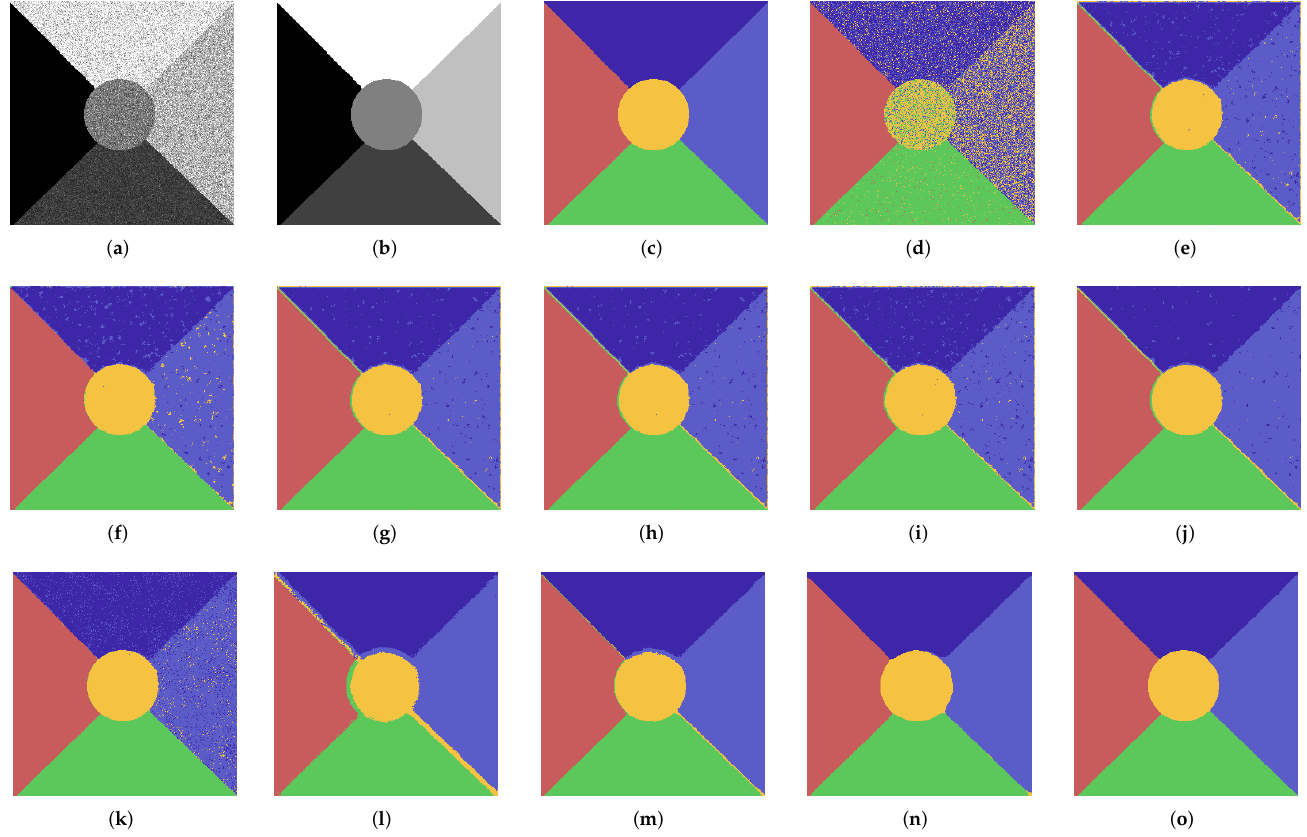
Figure 9. The segmentation results on the second simulated SAR image. ( a ) Original Image ( b ) Ground Truth (Gray) ( c ) Ground Truth (Color) ( d ) FCM ( e ) FCM_S1 ( f ) FCM_S2 ( g ) KFCM_S1 ( h ) KFCM_S2 ( i ) EnFCM ( j ) FGFCM ( k ) FCM_NLS ( l ) NS_FCM ( m ) RFCM_BNL ( n ) LBNL_FCM ( o ) GLR_FCM.